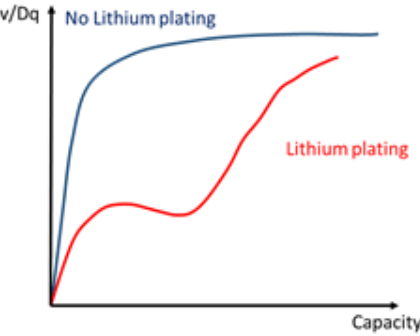
Figure 3. Differential Voltage Analysis (DVA) during discharge.